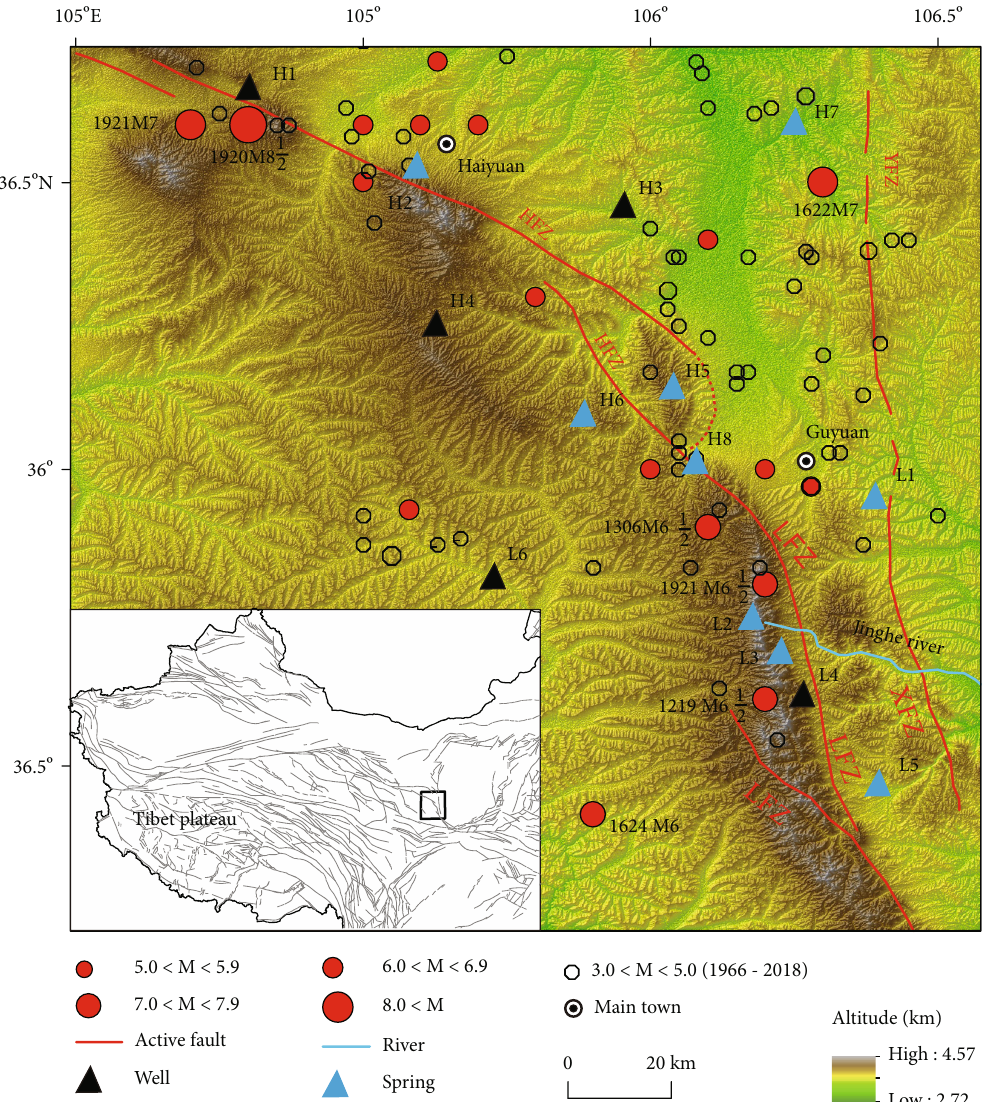
Figure 1: Topography map of the study region showing the main faults, epicentres of earthquakes and sampling locations (solid